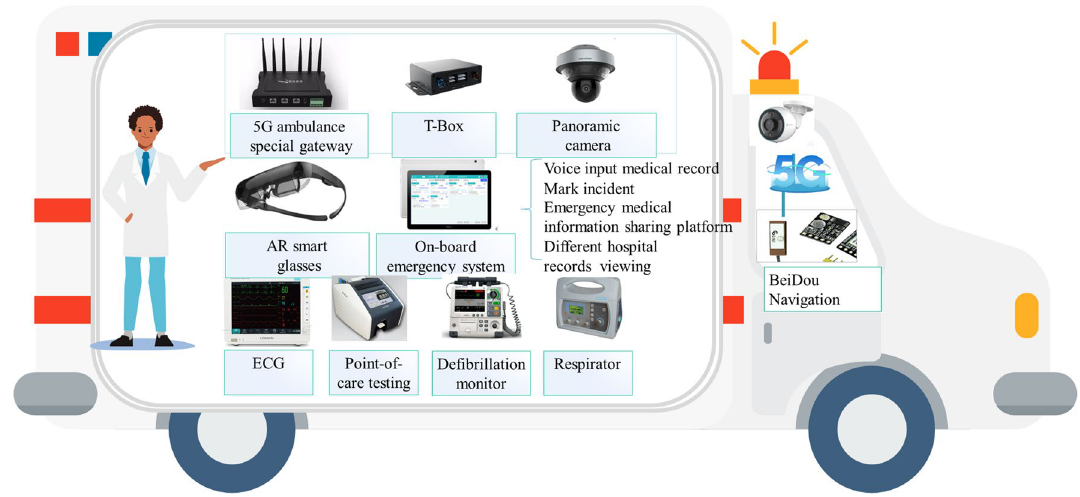
Figure 6. A schematic diagram of the reconstruction and deployment of ambulances.